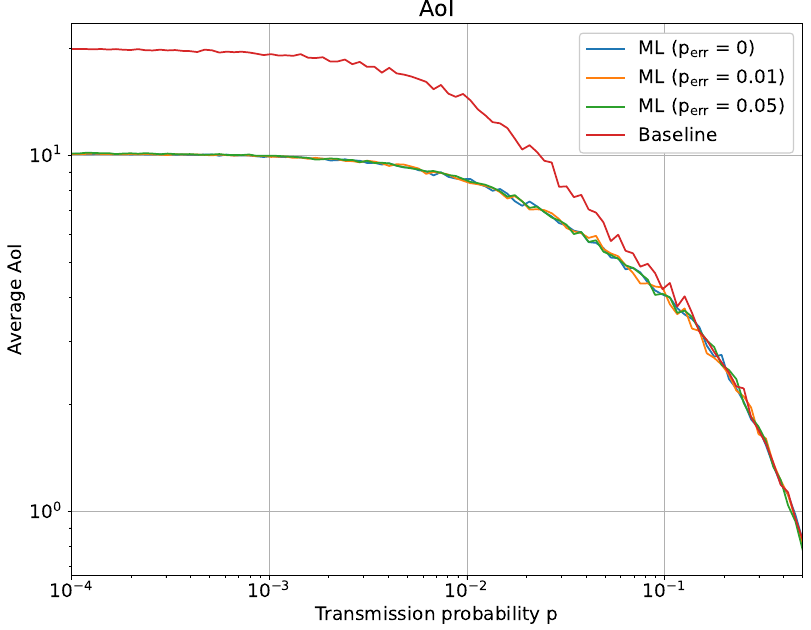
Figure 10. ML-based optimization of the sensor’s AoI: average AoI after 10 4 time